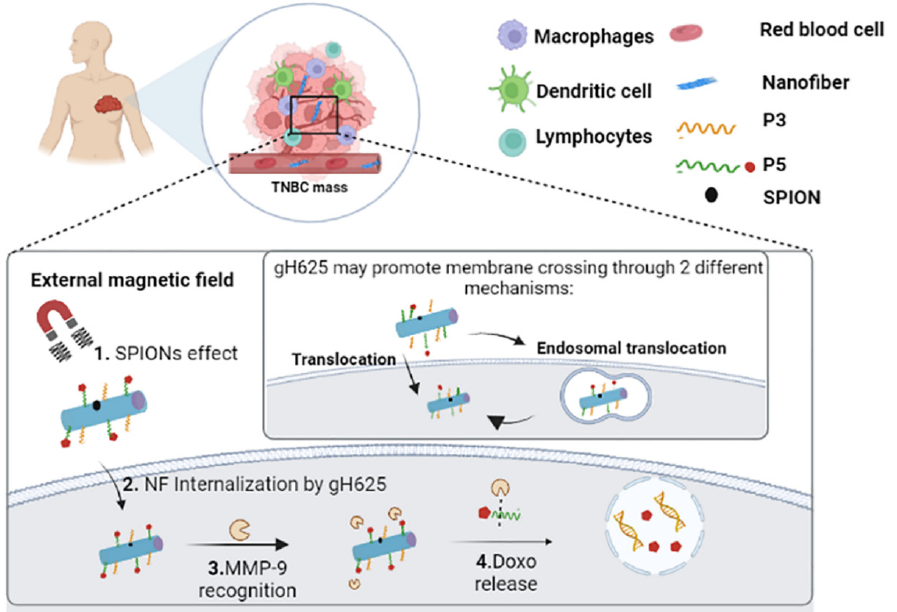
Figure 1. Schematic mechanism of action of the nanofibers. This Figure was created with BioRender.com (accessed on 28 December 2021).